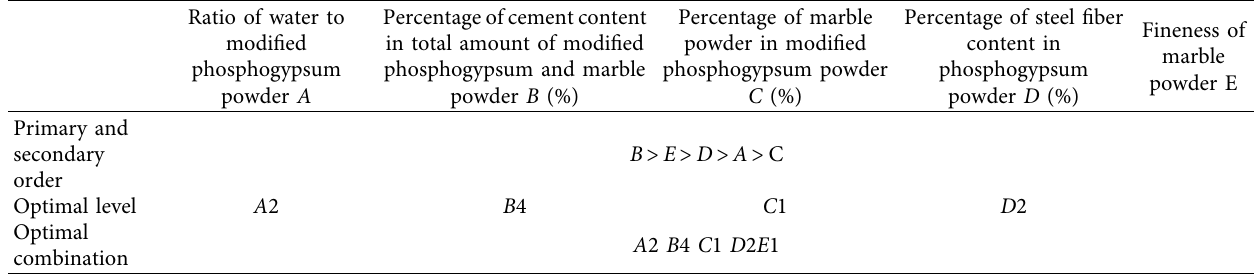
Table 13: Statistical table of the influencing factors of the 3d strength levels.